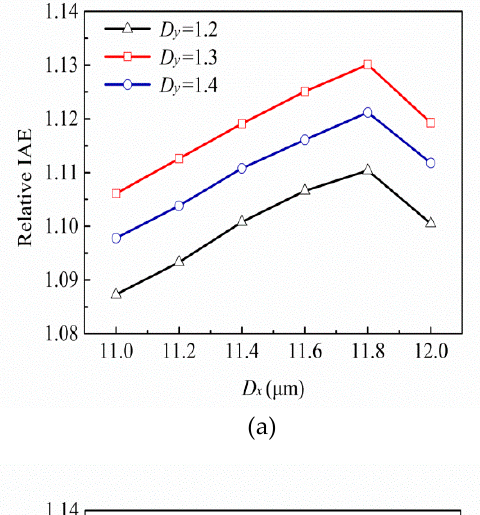
Figure 4. Variances of the relative infrared absorption efficiencies (IAEs) with different 𝑊 (cid:3051) and 𝑊 (cid:3052) for the thermopiles with RC-type ESCSs at the target temperature 75°, ( a ) one RC, ( b ) two RCs, and ( c ) three RCs.